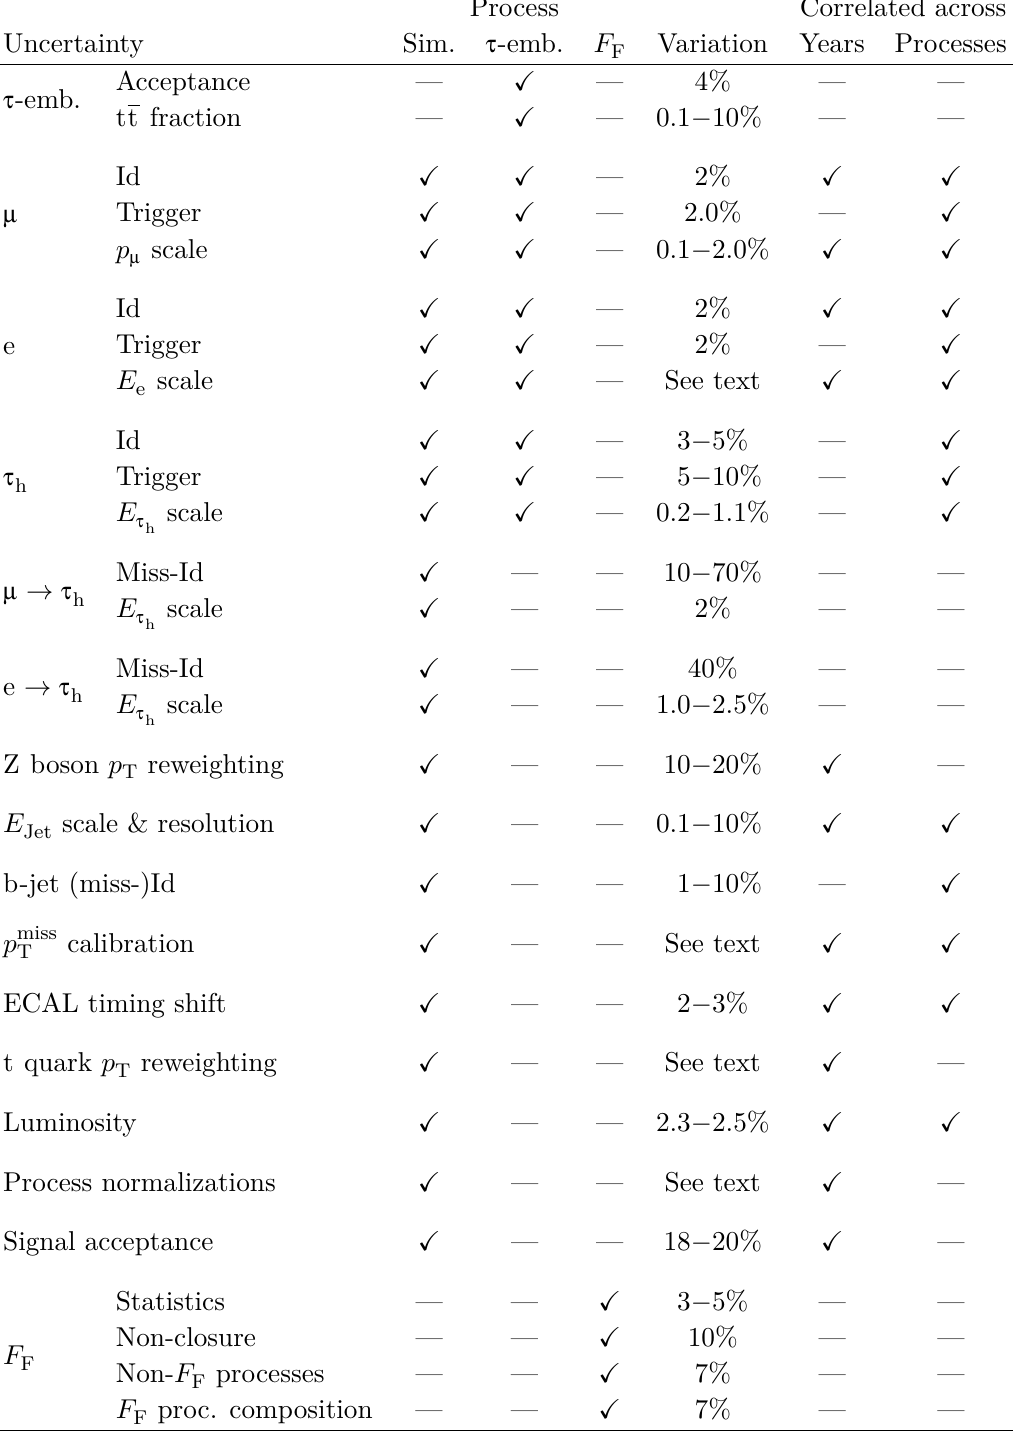
Table 3 . Summary of systematic uncertainties discussed in the text. The first column indicates the source of uncertainty; the second the processes that it applies to; the third the variation; and the last how it is correlated with other uncertainties. A checkmark is given also for partial correlations. More details are given in the